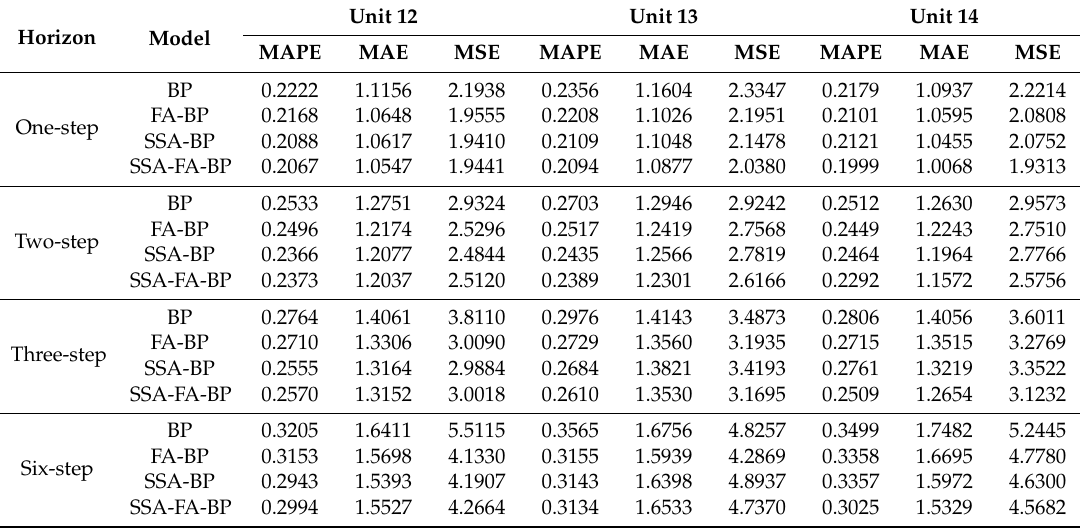
Table 7. The quarterly average forecast results of the combined model and the results of the other models involving the data of three units (60